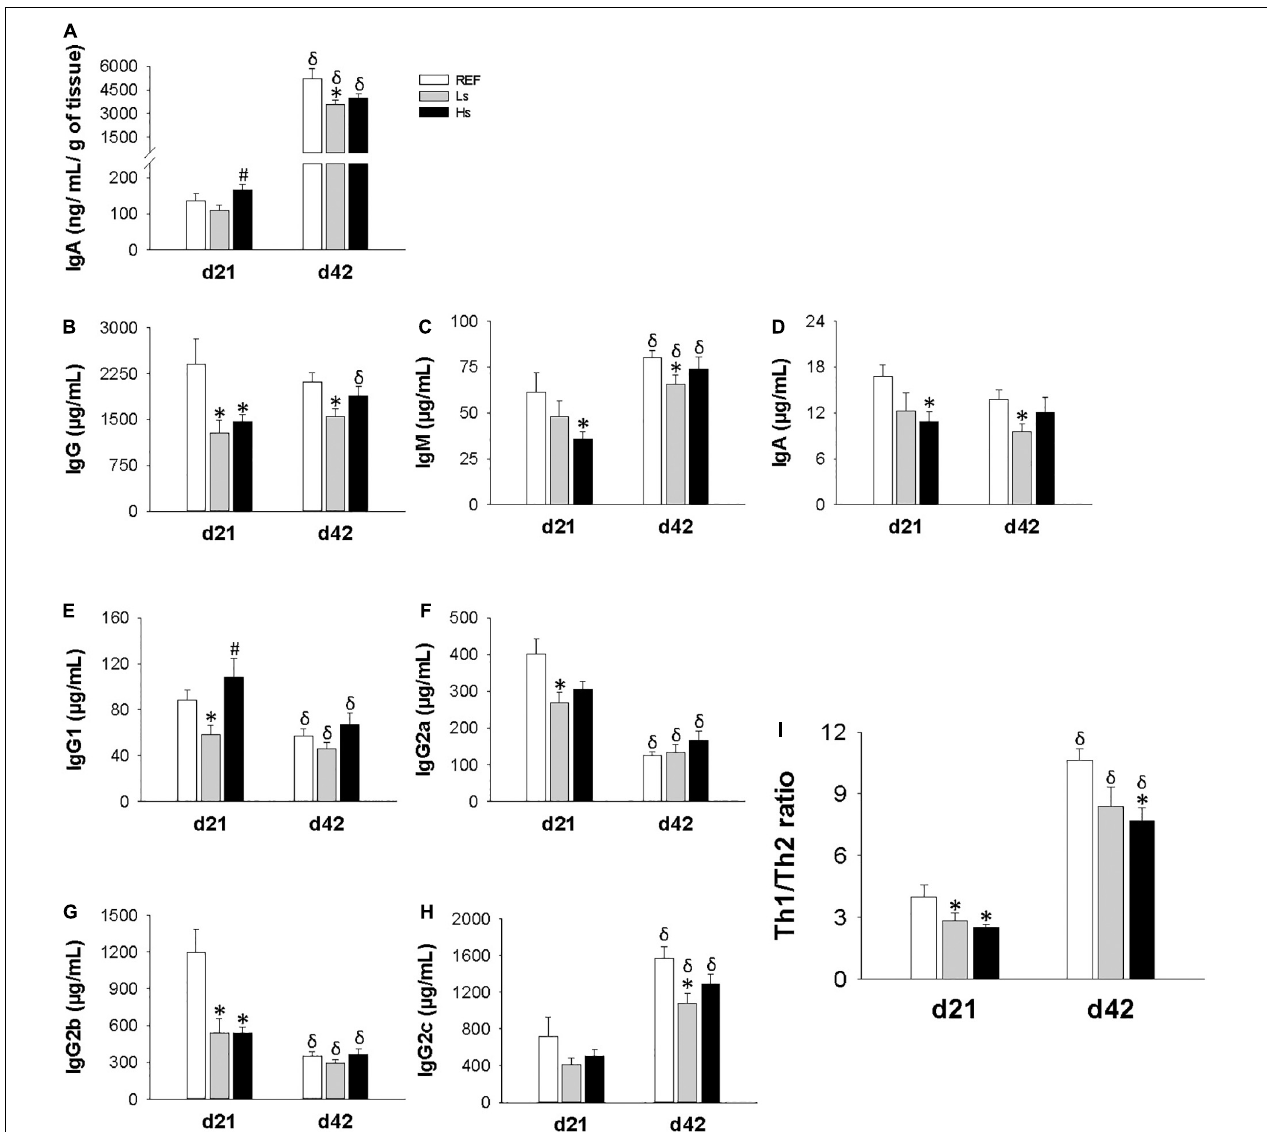
FIGURE 3 | Immunoglobulin concentration in different compartments at the end of the supplementation (day 21 of life) and 3 weeks after (day 42 of life; the end of the study). Intestinal IgA (A) , and plasma levels of Ig isotypes (B–H) , Th1/Th2 ratio (I) refers to the relationship between Th1 associated Ig (IgG2b + IgG2c) and Th2 associated Ig (IgG1 + IgG2a). Results are expressed as mean ± SEM ( n = 12 animals/group). Statistical differences: ∗ p < 0.05 vs. REF, # p < 0.05 Hs vs. Ls and δ day 42 vs. day 21. REF, reference group; Ls, group supplemented with low dose of S. epidermidis and Hs, group supplemented with high dose of S. epidermidis